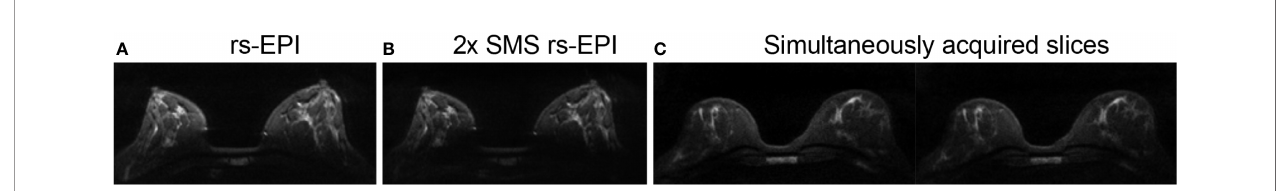
FIGURE 3 | Example of SMS rs-EPI acquisition at b=800 s/mm 2 in a 35-year-old healthy volunteer, wherein (B) two-fold (2×) SMS rs-EPI maintains comparable image quality as (A) conventional rs-EPI while reducing scan time in a 3T scanner. Panel (C) shows two simultaneously acquired slices used to generate a single- band equivalent image for the same patient at a different slice location (94). (Courtesy of Lukas Filli, MD, Zurich,